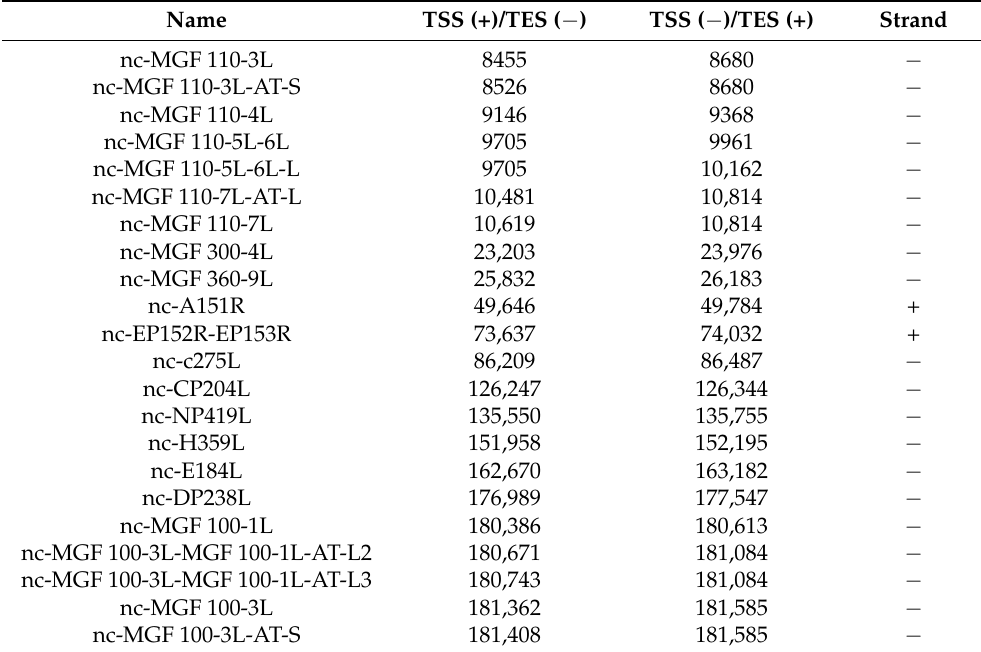
Table 3. List of the non-coding